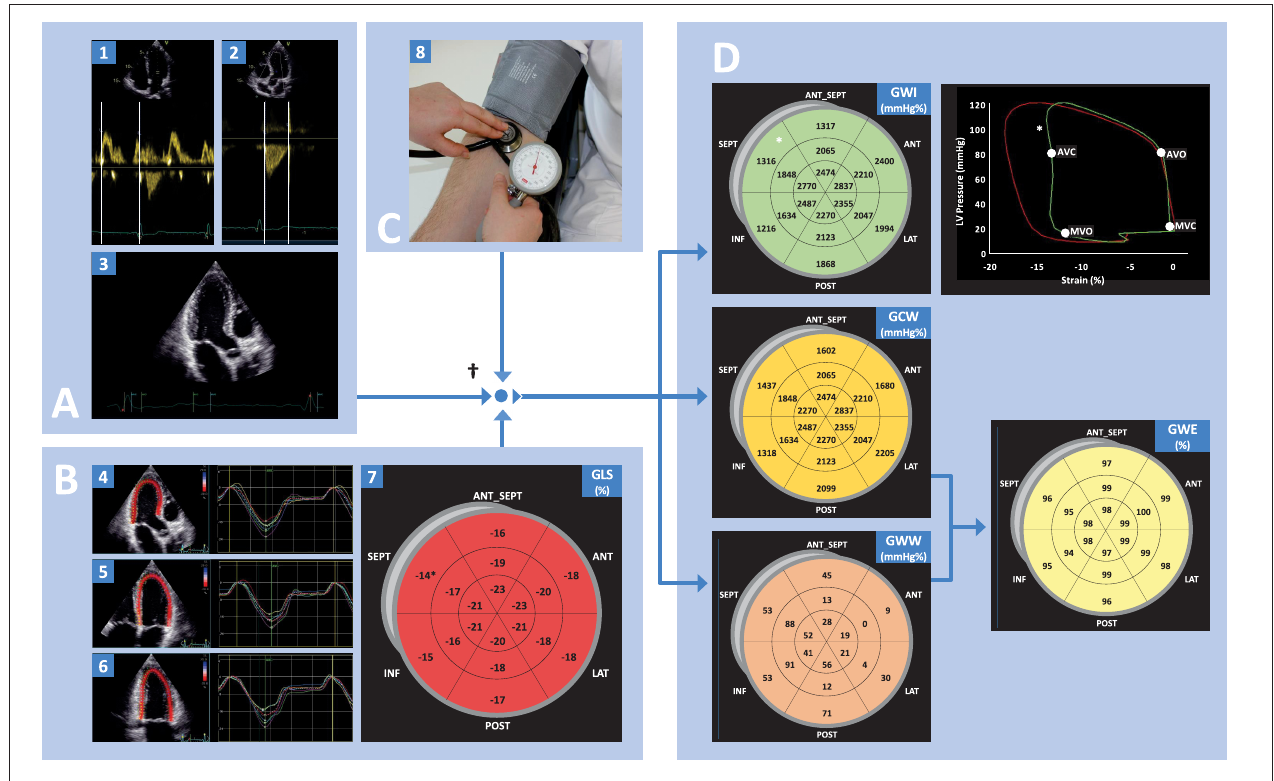
FIGURE 2 | Illustrative physiological background of LV myocardial work analysis. (A) Represents valvular times, with mitral valve opening and close measured using pulse-waved Doppler derived mitral inflow and aortic valve opening and closure measured by continuous-wave Doppler derived transaortic outflow. (B) Global longitudinal strain measured from 4, 3, and 2 chamber view. (C) Estimated LV Pressure measured from brachial cuff pressure. (D) Schematic presentation of segment-specific values of MyW indices, which later are expressed in global values. GCW and GWW are important physiological indices related to the shortening and lengthening of the LV segments. Work efficiency (GWE) is derived as the fraction of GCW and the sum of GCW and GWW. suggested in the validation study by Russell et al. ( 8). * indicates a segment-specific pressure-strain loop (in this case, we highlighted the septal basal